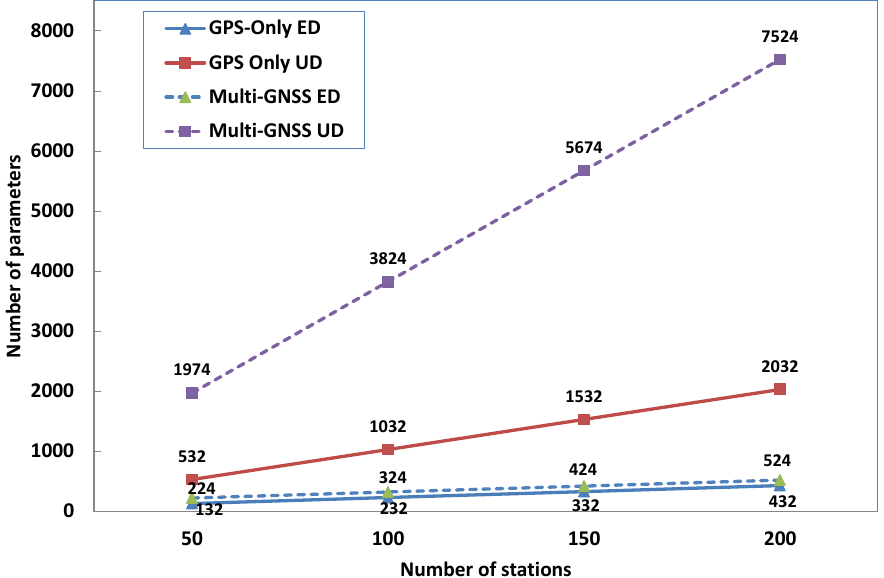
Figure 1. Relationship between the number of stations and number of parameters for the solutions using epoch-differenced (ED) or undifferenced (UD) model and for global positioning systems (GPS) or multi-GNSS (global navigation satellite systems).